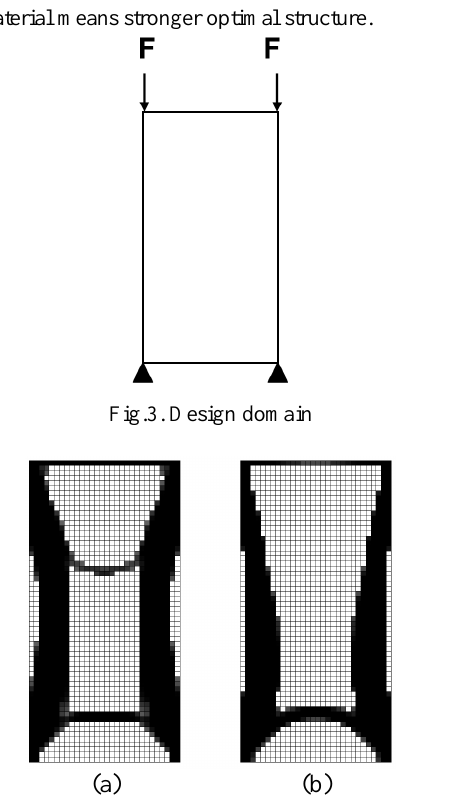
Fig.4. Optimized structures with and without considering body forces